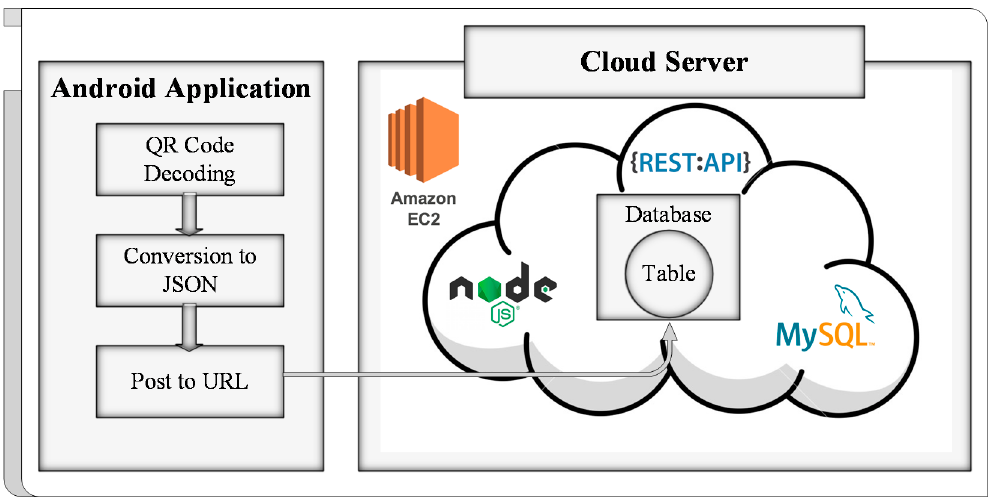
Figure 5. Basic framework of data storage.